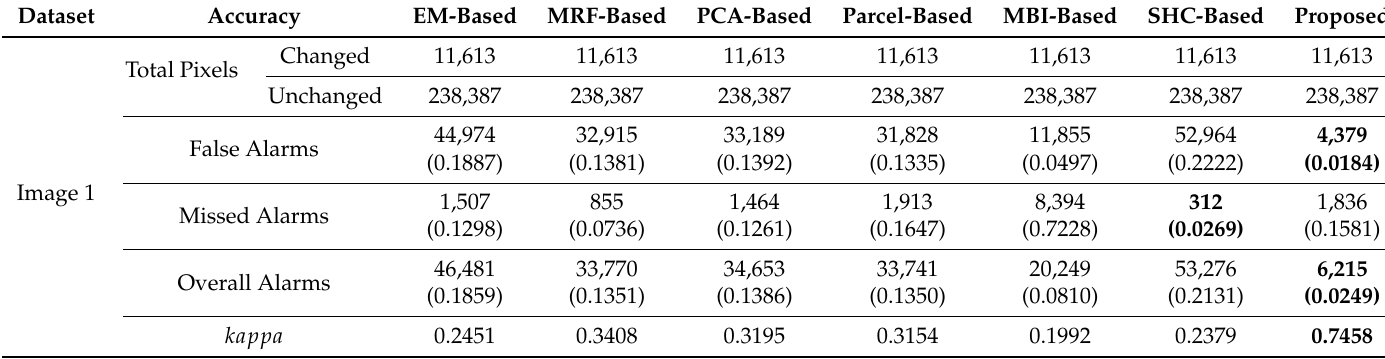
Table 2. Performance comparisons against different approaches on the second set of image pairs. (Image 1–Image 5 respectively correspond to five image pairs from top to bottom in Figure